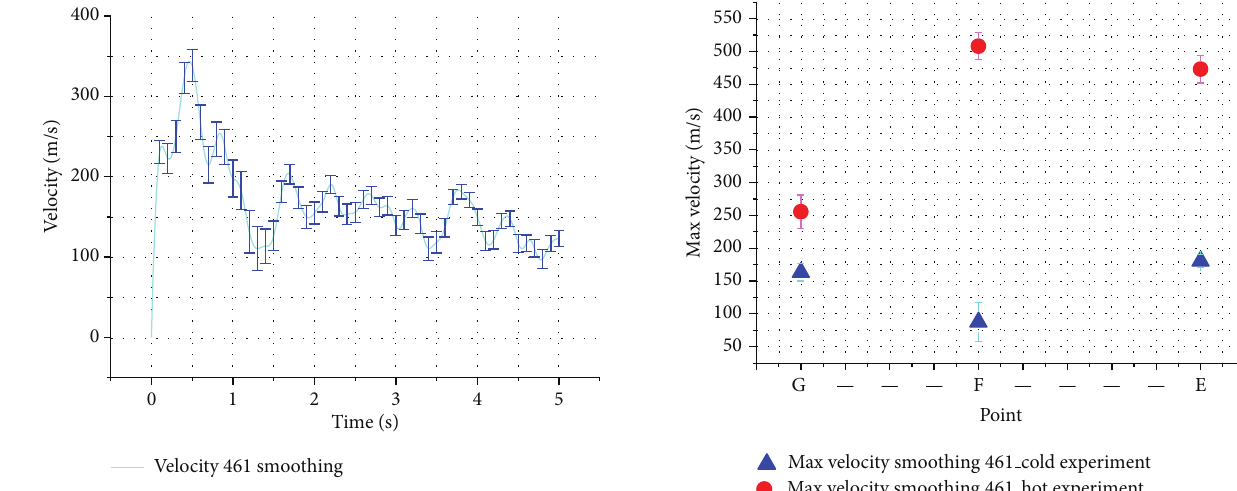
Figure 22: Division of the half tank into four lines.